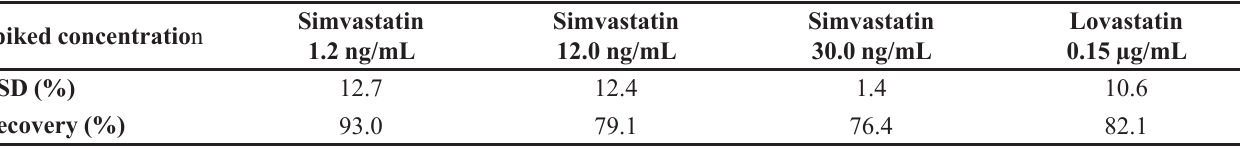
TABLE II - Extraction recovery of simvastatin and lovastatin Spiked concentratio